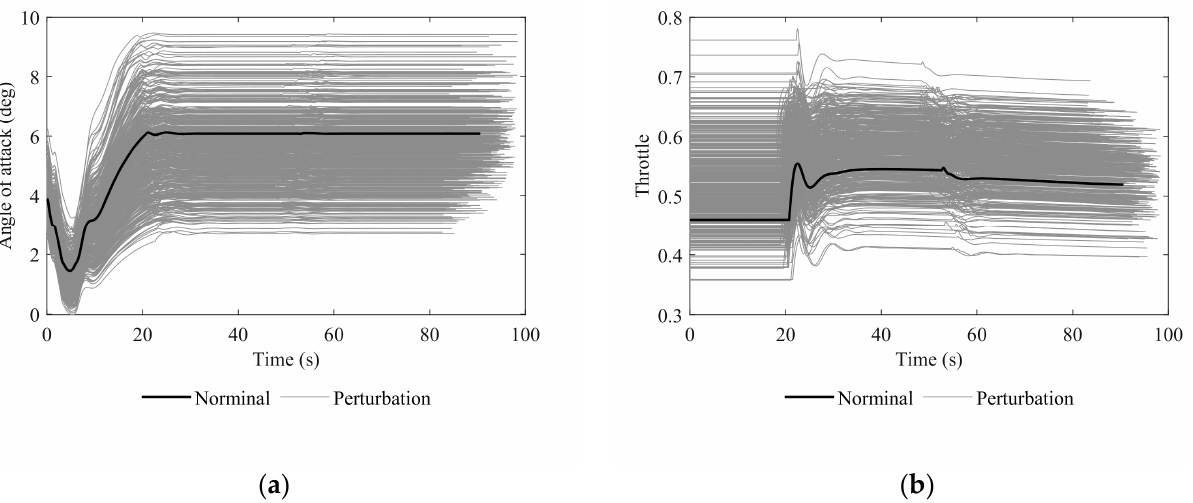
Figure 25. States response of the MC simulation: ( a ) angle-of-attack response and ( b ) throttle response.